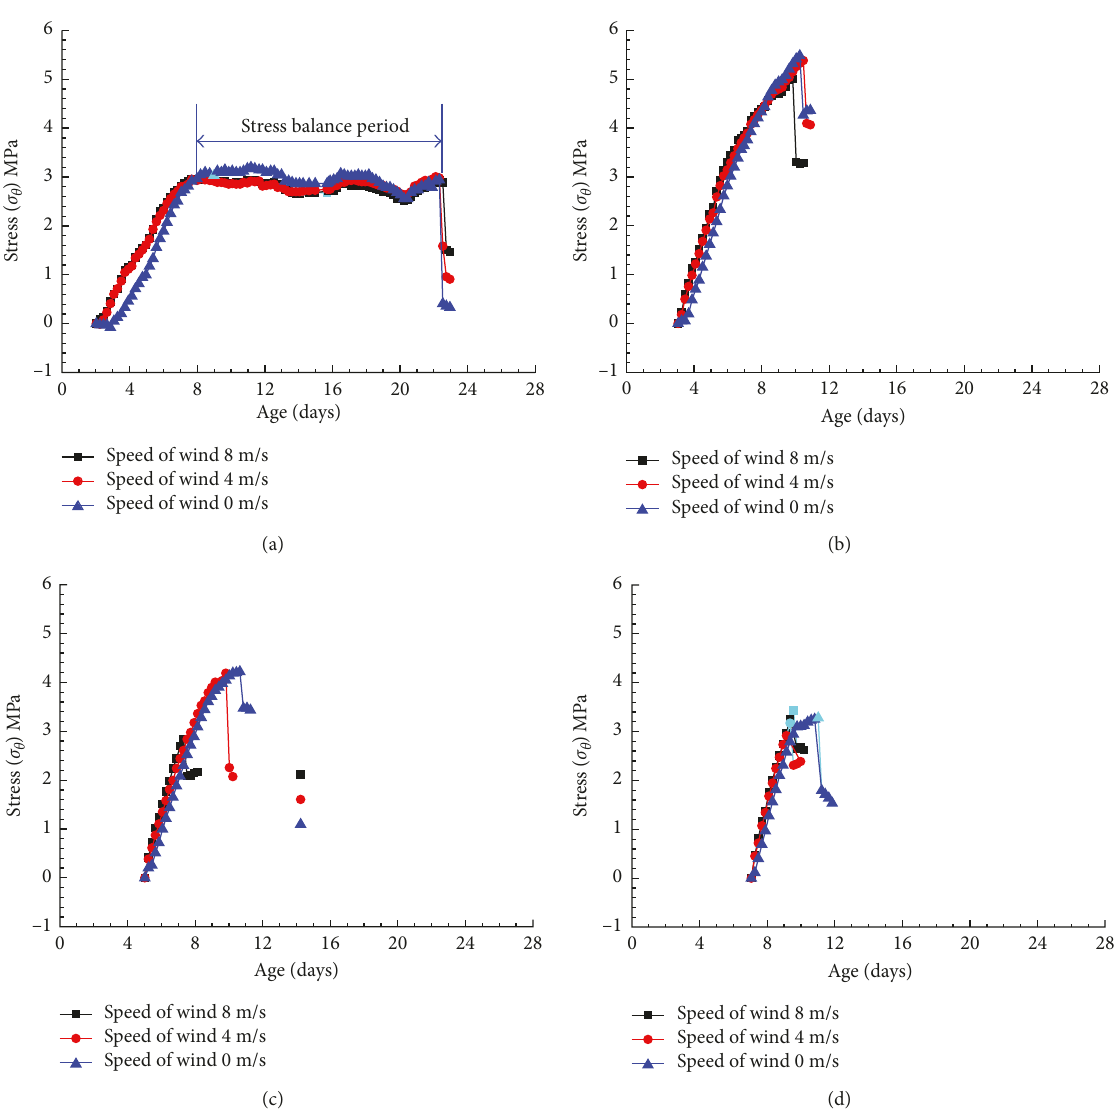
Figure 8: Shrinkage stress with different moisture curing ages. (a) 2 days. (b) 3 days. (c) 5 days. (d) 7